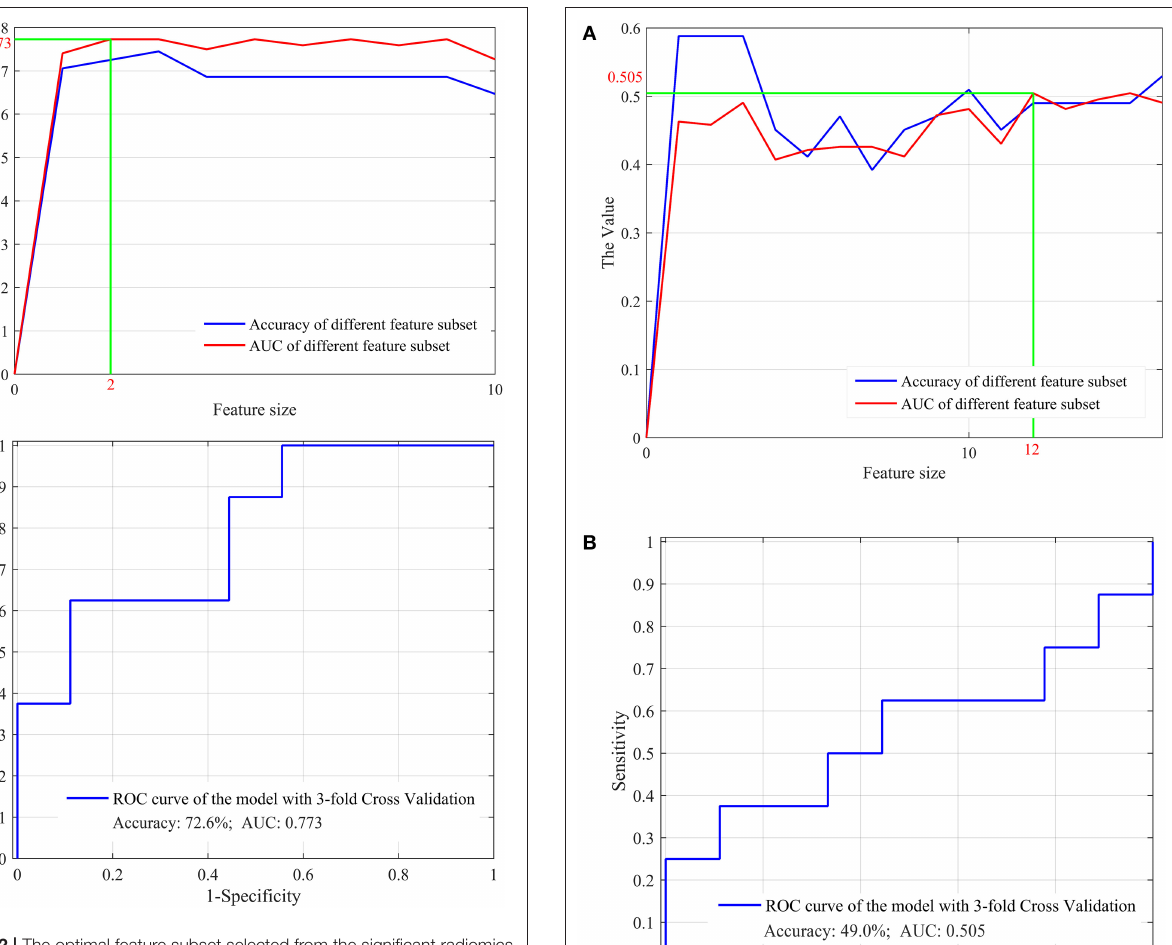
and an SVM classifier, and its overall performance with 3-fold CV and 100-round classification was fair and acceptable, as shown in Figure 2B